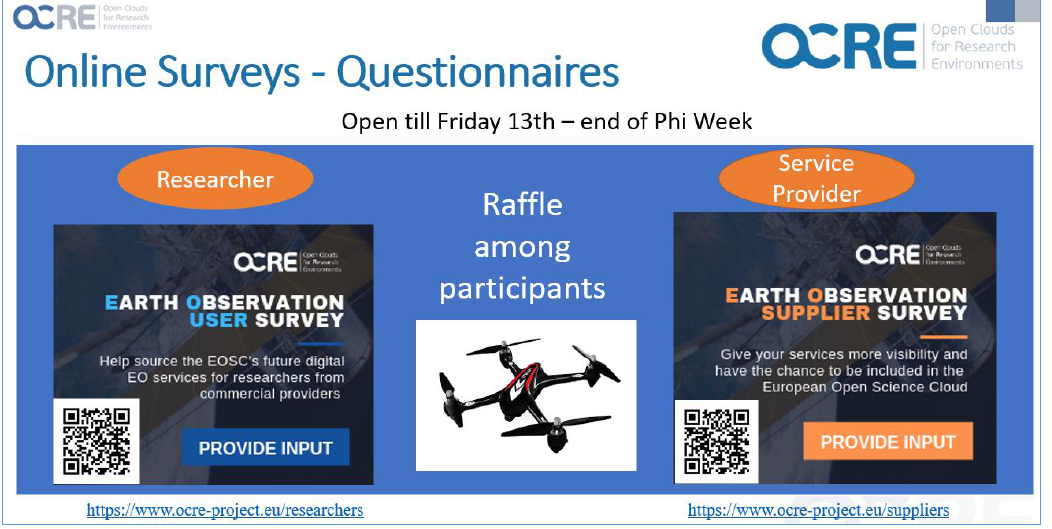
Figure 6. Announcement of the online surveys during conference presentation.